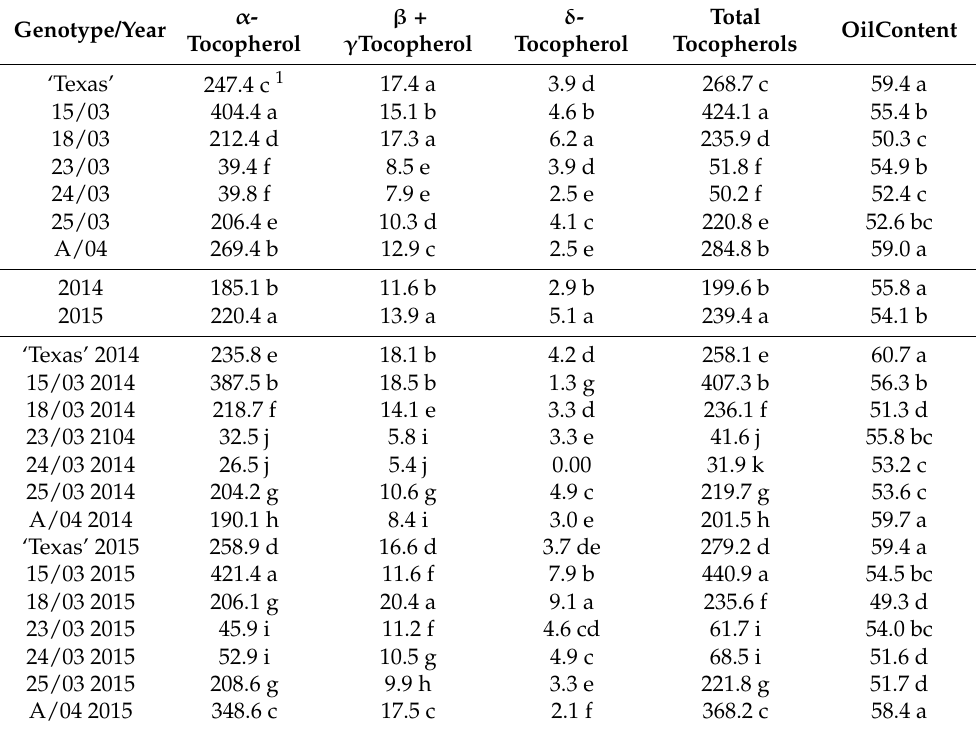
Table 4. The oil content (%) and the composition of the tocopherols (mg/kg of